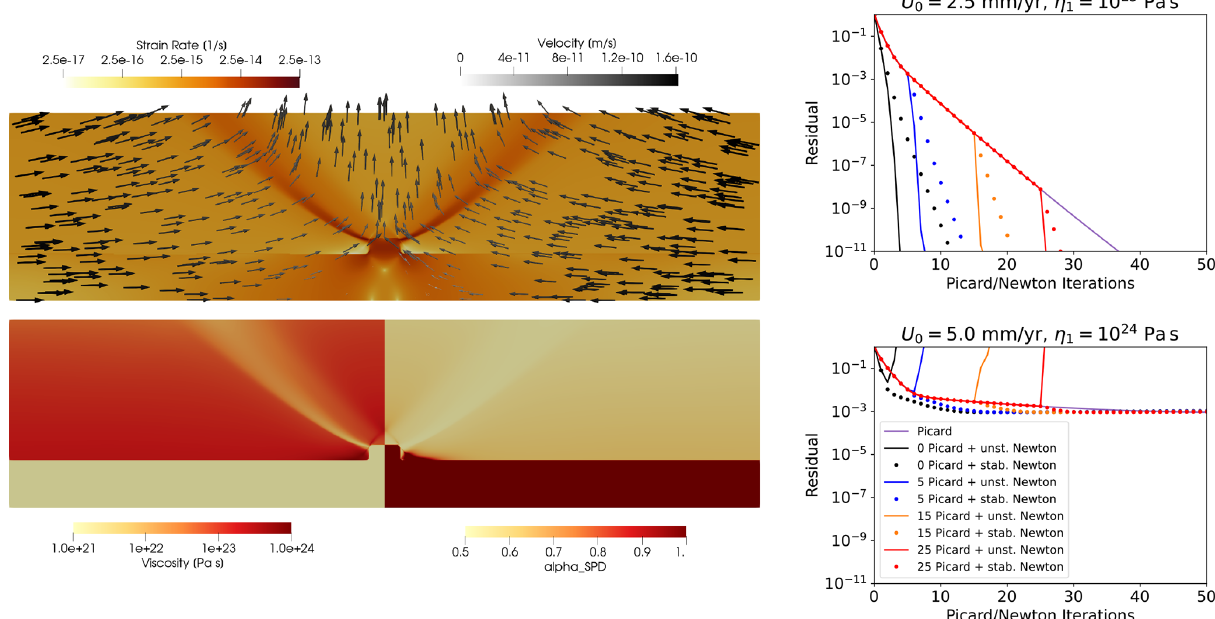
Figure 12. Benchmark case of Spiegelman et al. (2016) with strain-rate- and pressure-dependent Drucker–Prager rheology. Solution fields, including velocity, strain rate, viscosity and α SPD (see Eq. 43), are shown for the case with inflow velocity U 0 = 5mmyr − 1 , η 1 = 10 24 Pas and a friction angle of α = 30 ◦ in the left panel. The top-right and bottom-right panels show convergence of the residual in the Picard and Newton solvers applied to the U 0 = 2 . 5mmyr − 1 , η 1 = 10 23 Pas case and the U 0 = 5mmyr − 1 , η 1 = 10 24 Pas case respectively. Both cases are run with a number of initial Picard iterations, as indicated in the legend, before switching to either the full unmodified Newton method (solid lines) or the stabilised method with modifications as proposed in Fraters et al. (2019) (dots). In the former case, the unmodified Newton method clearly performs best, with the stabilised method showing some degradation towards the Picard method (purple line). In the latter case, the unmodified Newton method fails to converge, whereas the stabilised method continues to converge slowly but not much faster than the Picard method, before stalling altogether. These results are generally consistent with those in Fraters et al.